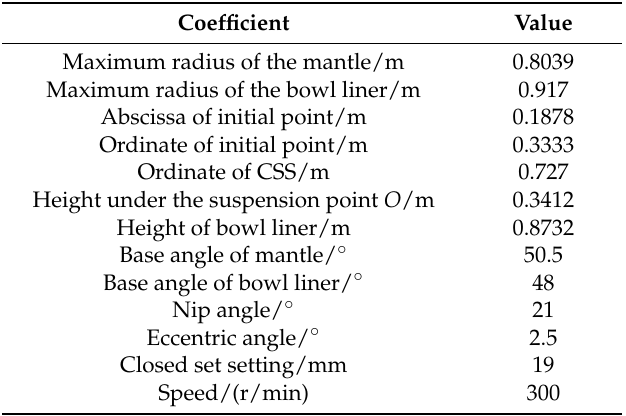
Table 3. Structural parameters of crushing chamber and operating